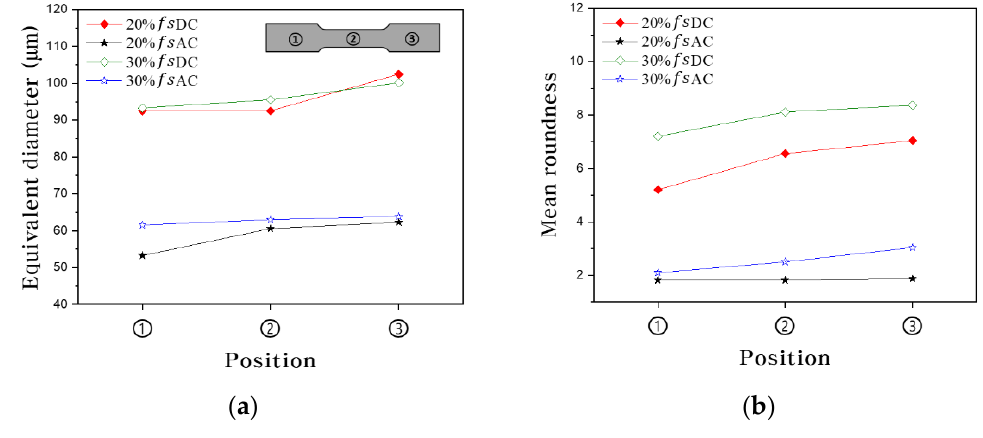
Figure 8. Optical micrographs showing the microstructure of A356 according to the current input method: ( a ) 20% 𝑓𝑠 , ( b ) 30% 𝑓𝑠 .